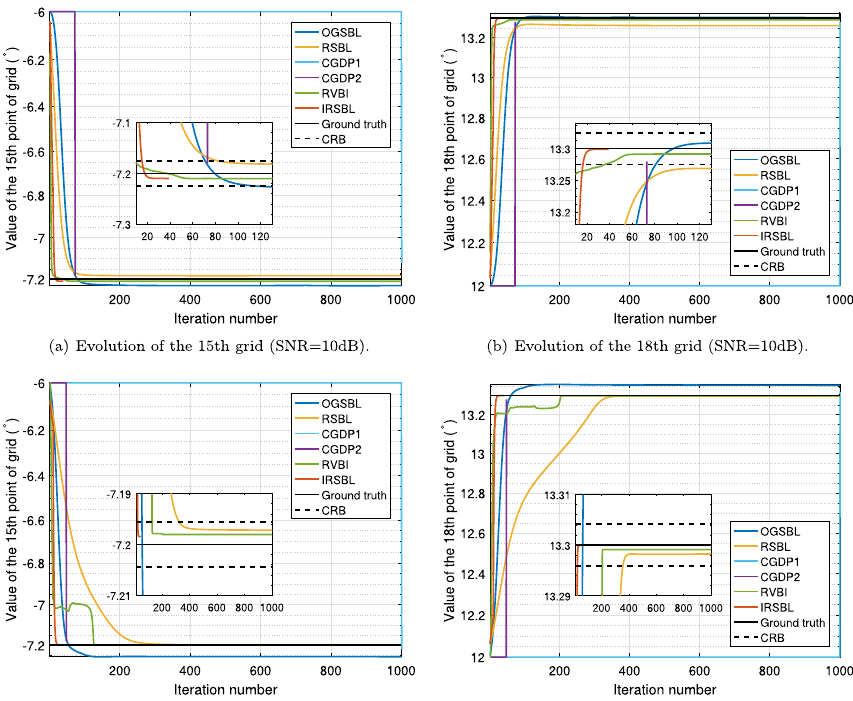
Fig. 6 Evolution of grid points closest to true